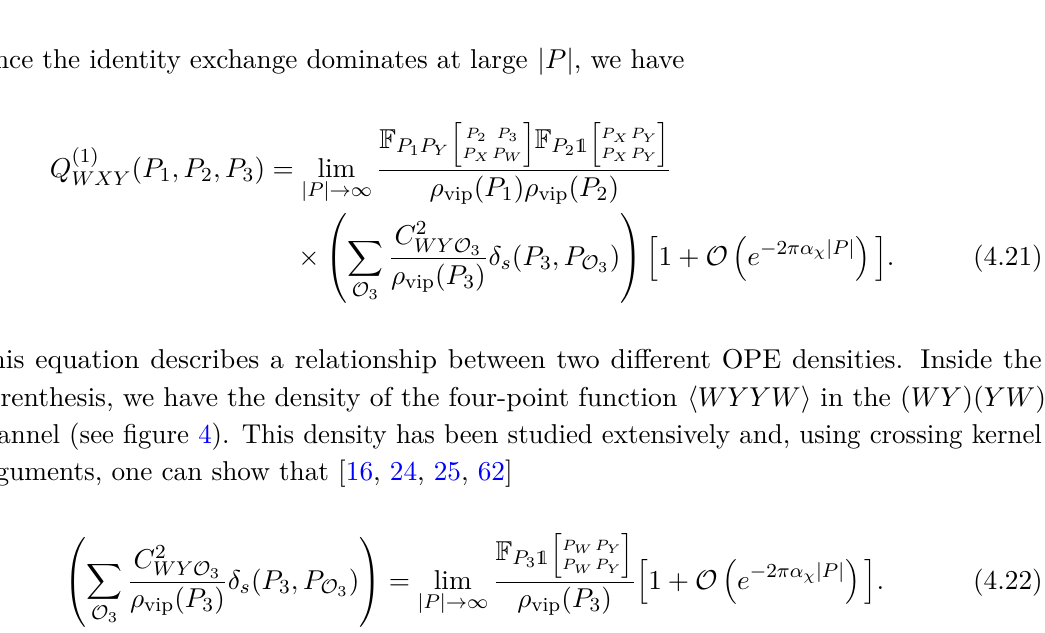
Figure 5 . The OPE diagram on the left can be reduced to the one on the right by an application of two crossing